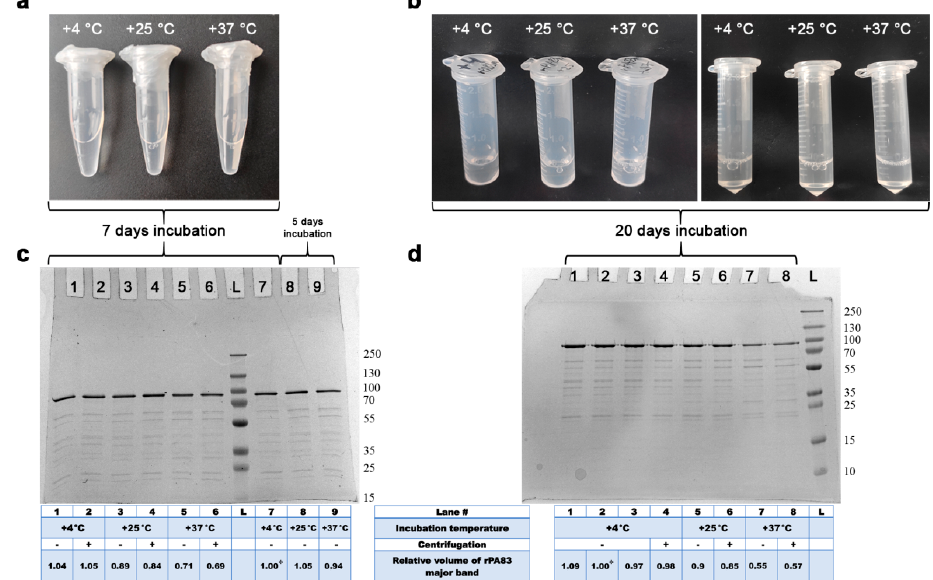
Figure A3. Analysis of rPA83m aggregation state. ( a , b ) Visual assessment of rPA83m (C = 0, 47 µg/mL) aggregation state after storage at +4 °C, +25 °C or +37 °C for 7 days ( a ) or 20 days ( b ). ( c , d ) Freshly prepared rPA83m (C = 0.47 µg/mL) was aliquoted and incubated at +4 °C (c: lanes 1, 2, 7 and d: lanes 1–4), +25 °C (c: lanes 3, 4, 8 and d: lanes 5, 6) or +37 °C (c: lanes 5, 6, 9 and d: lanes 7, 8). Samples were incubated for 5 days (c: lanes 8 and 9), 7 days (c: lanes 1–7) or 20 days (d). Thoroughly mixed incubated samples (c: lanes 1, 3, 5, 7 and d: lanes 1–3, 5 and 7) as well as supernatant of incubated samples after centrifugation (16,100× g , 20 min) (c: lanes 2, 4, 6 and d: lanes 4, 6, 8) were analysed using SDS-PAGE electrophoresis. For each analysed sample an equal volume (equal to the volume containing 1 µg of freshly prepared rPA83m) was loaded on the corresponding lane. L—protein molecular mass ladder (molecular weights, in kDa, are indicated on the right). The relative volume of a major rPA83m band was calculated through comparing it with a reference band (*). The calculation was performed using ChemiDoc XRS+ gel documentation system software.